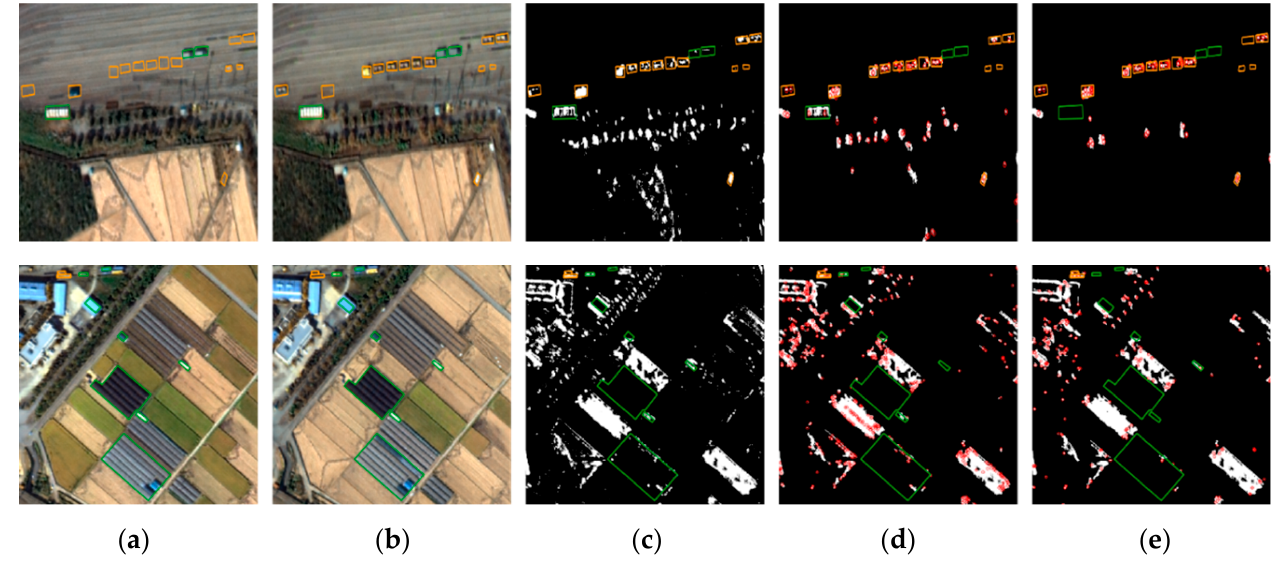
Figure 9. Comparison of pixel-based and feature point-based change detection results for Chilgok: ( a ) before images, ( b ) after images, ( c ) pixel-based results, and feature-based results using ( d ) SIFT, and ( e ) AKAZE.